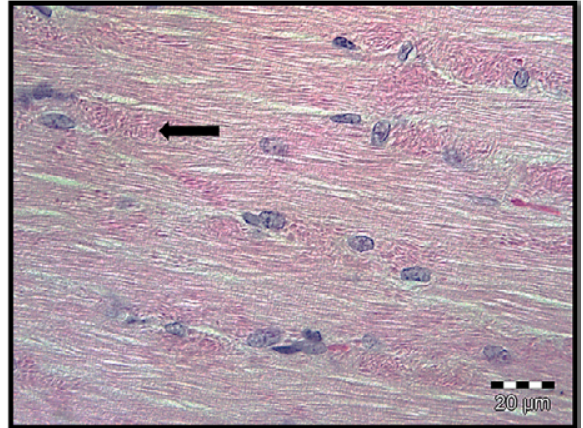
Figure 6a: Haematoxylin and eosin stain on a formalin-fixed wax-embedded section of m. biceps femoris demonstrating the nemaline rods (arrow) staining red in all fibres, not easily visualised against the similar-coloured sarcoplasm. Light microscopy, magnification x1000, oil immersion.